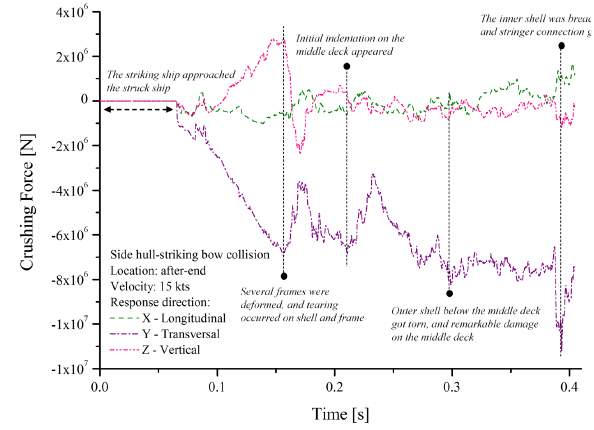
Figure 10: Force criterion and behaviour of the failure on the side hull: midsection impacted by velocity 15